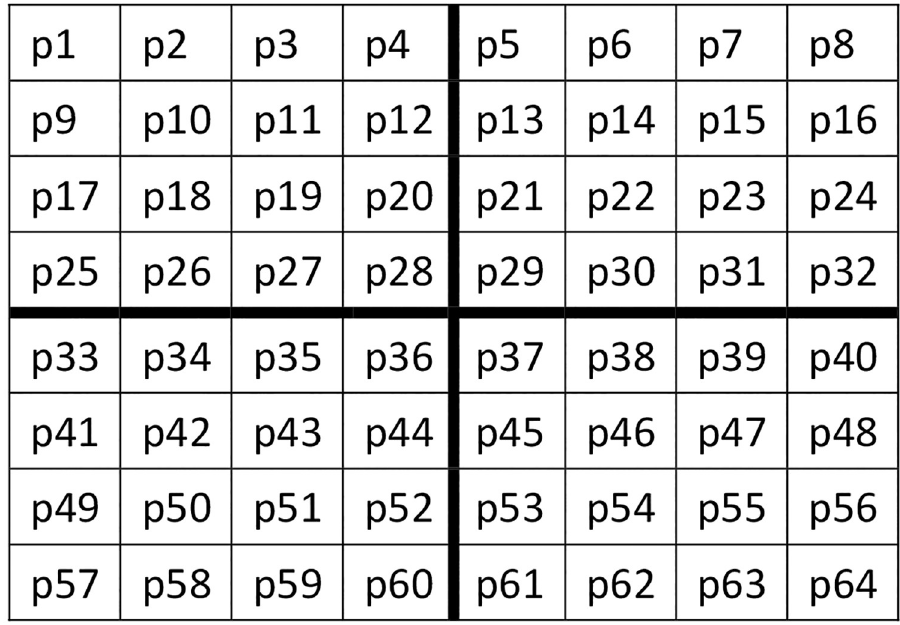
Fig 6. Pixel block